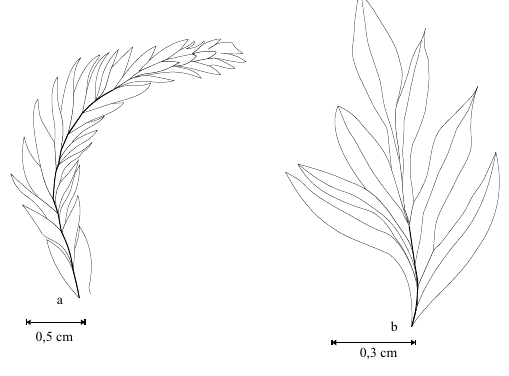
Fig. 2 – Coricladus quiteriensis sp. nov. vegetative branches: (a) apical portion of a branch, demonstrating the disposition of the leaves – PbU 191; (b) apical portion of a branch, demonstrat- ing the conspicuous central vein at the leaves – PbU